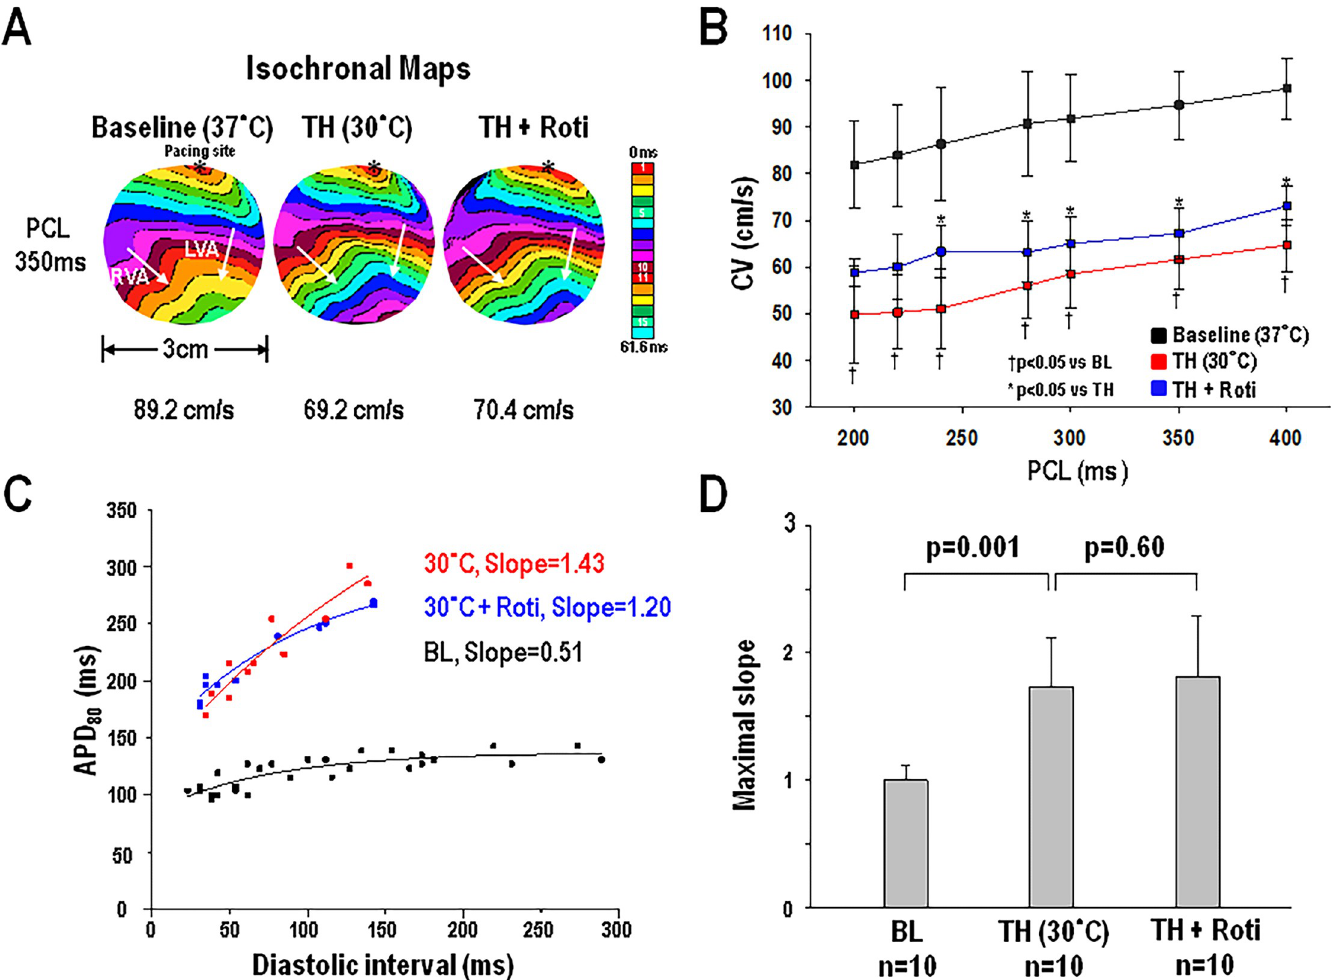
Fig 1. A, representative isochronal maps (from heart #10) at pacing cycle length (PCL) 350 ms during baseline (BL, 37˚C), therapeutic hypothermia (TH, 30˚C), and after rotigaptide (Roti) infusion. These maps are constructed by consecutive frames shown in different colors (1 frame = 3.85 ms), and used for evaluation of ventricular conduction velocity (CV). The average CVs of each stage are shown below. � Pacing site. B, CVs during these 3 stages at different PCLs. C, representative action potential duration (APD) restitution curves from a site at left ventricle (from heart #9) during these 3 stages. D, maximal slope of APD restitutions at there 3 stages.